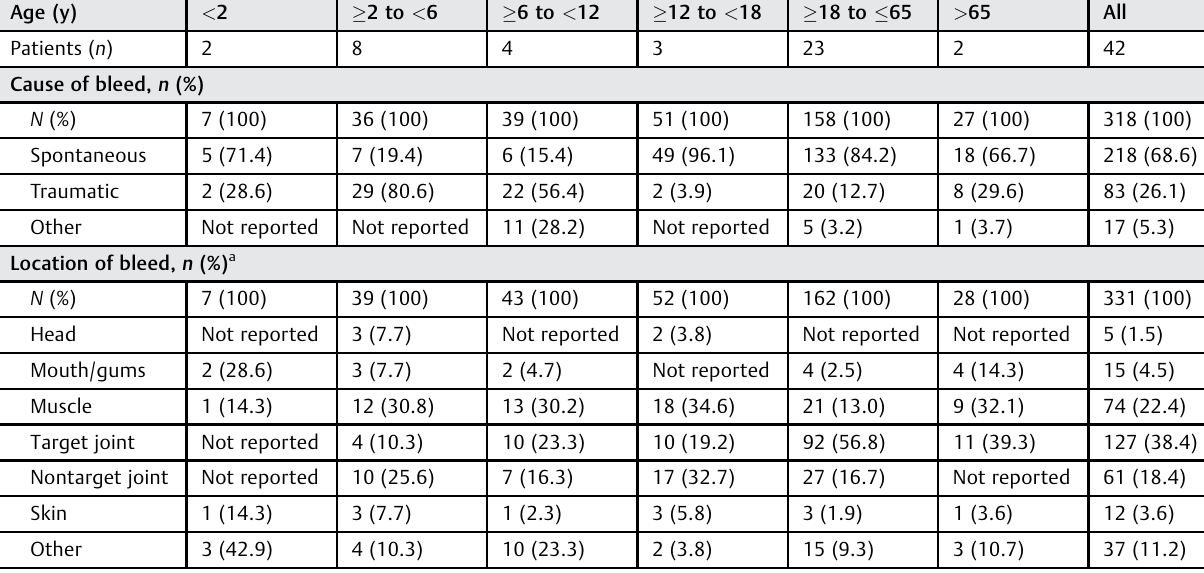
Table 2 Characteristics of bleeding episodes treated (cid:1) 1 hour from bleed onset with rFVIIa (NovoSeven ® ) monotherapy in SMART-7 ™ overall and by age